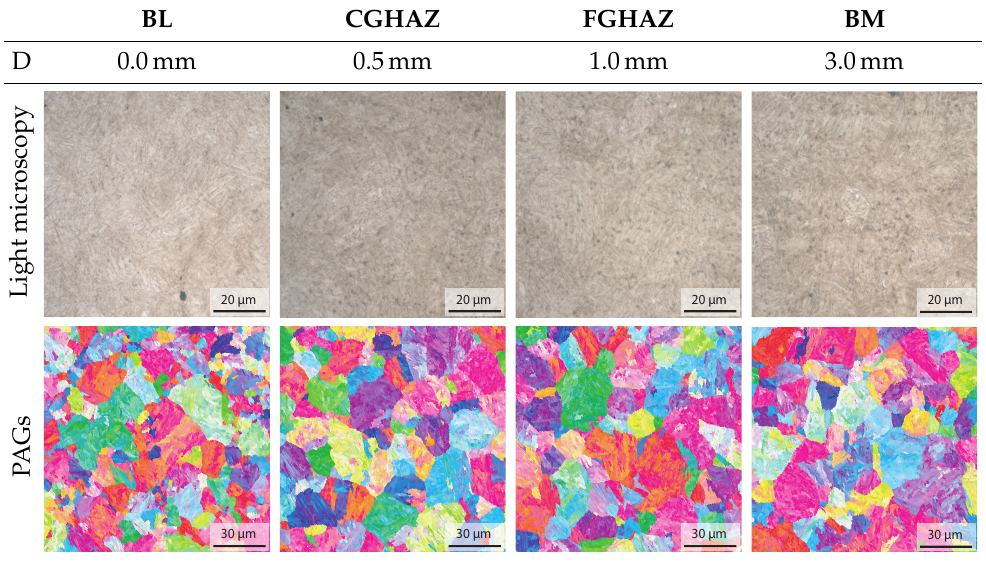
Table 5. Light optical microscopy images and prior austenite grain size (PAGs) of the bonding line (BL), coarse and fine grained heat affected zone (CGHAZ, FGHAZ) and the base material (BM) of the weld seam in the hardened state at different distances (D) from the bonding